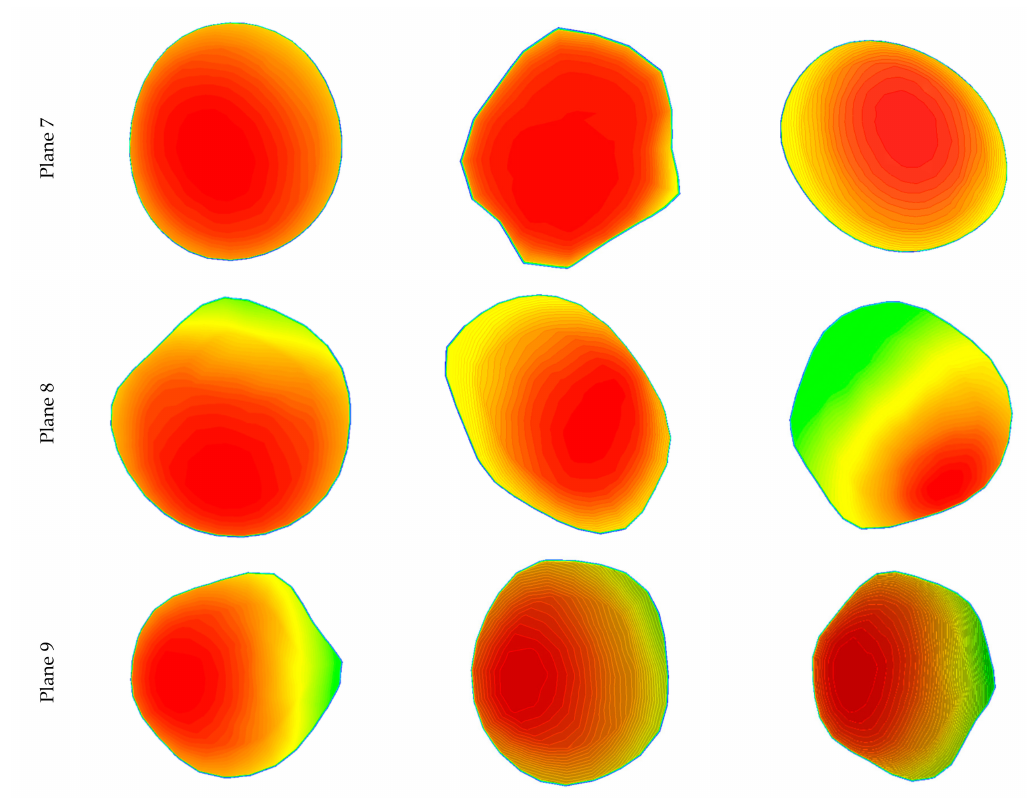
Figure 8. Velocity contours at di ff erent positions of the healthy and stenosis airways at 30 lpm: ( a ) healthy model (left panel), ( b ) stenosis on the right, and ( c ) stenosis on the